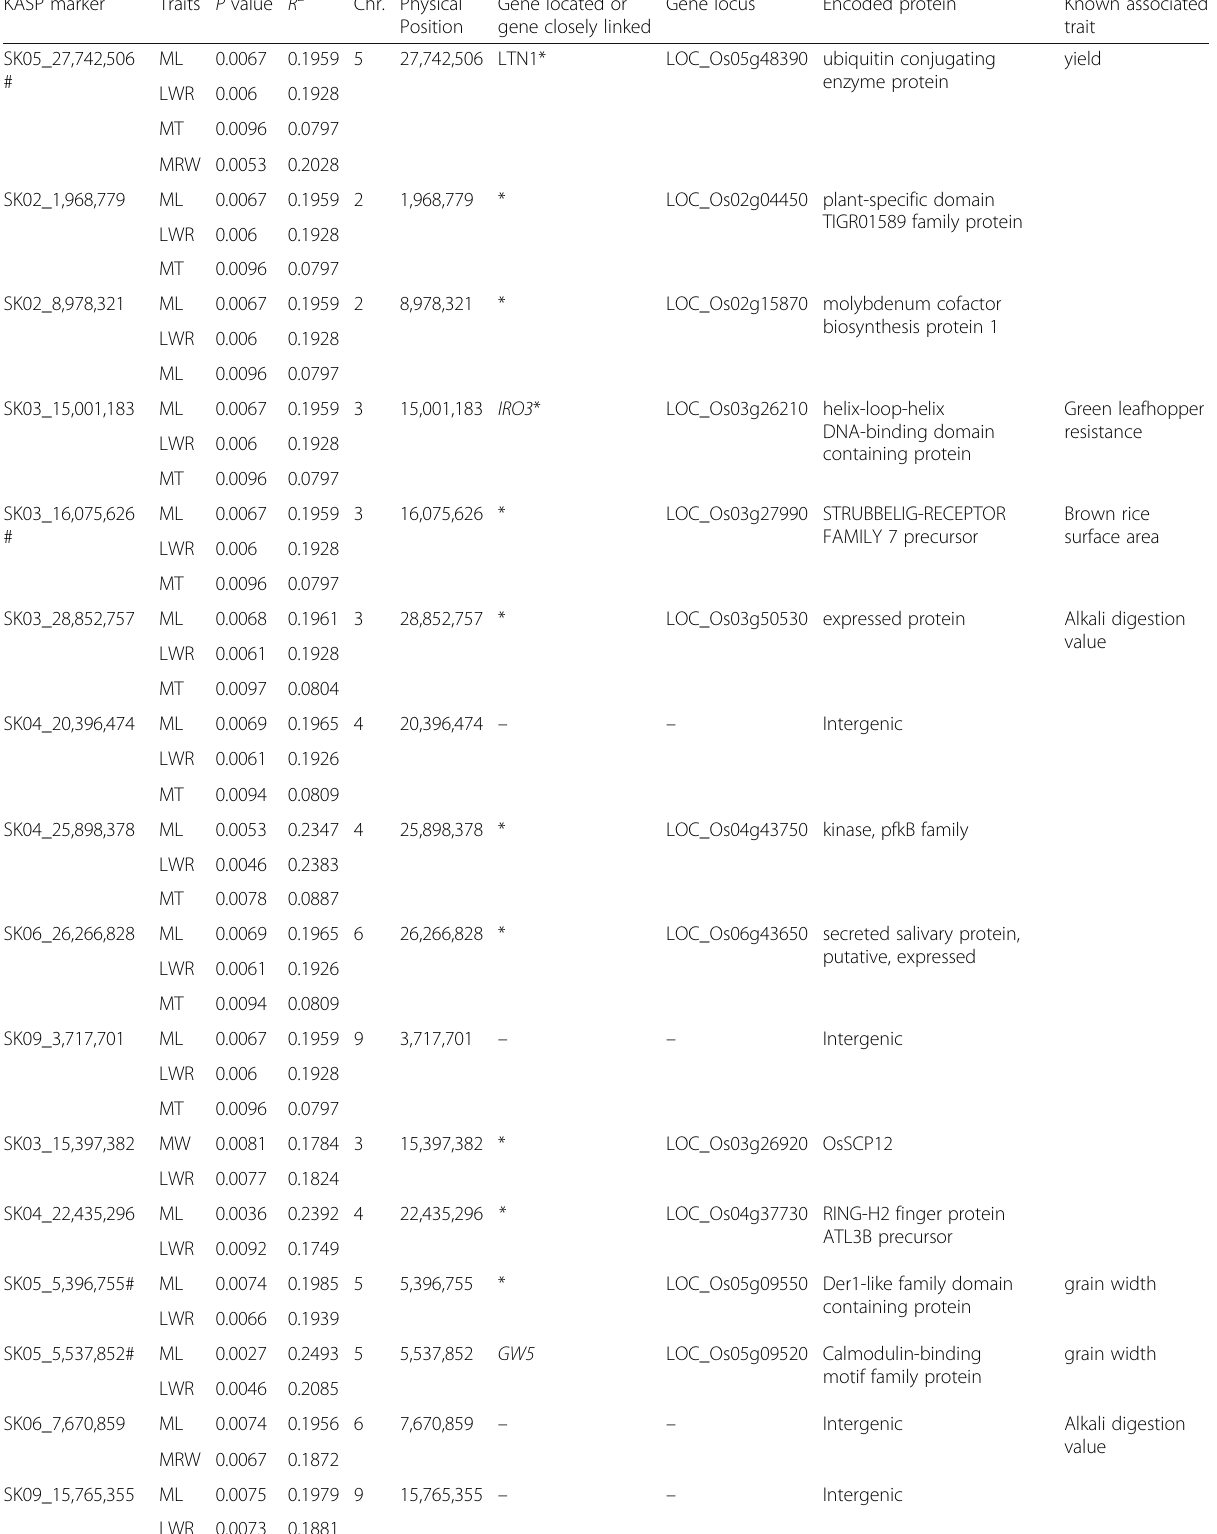
Table 6 Associations between KASP markers and